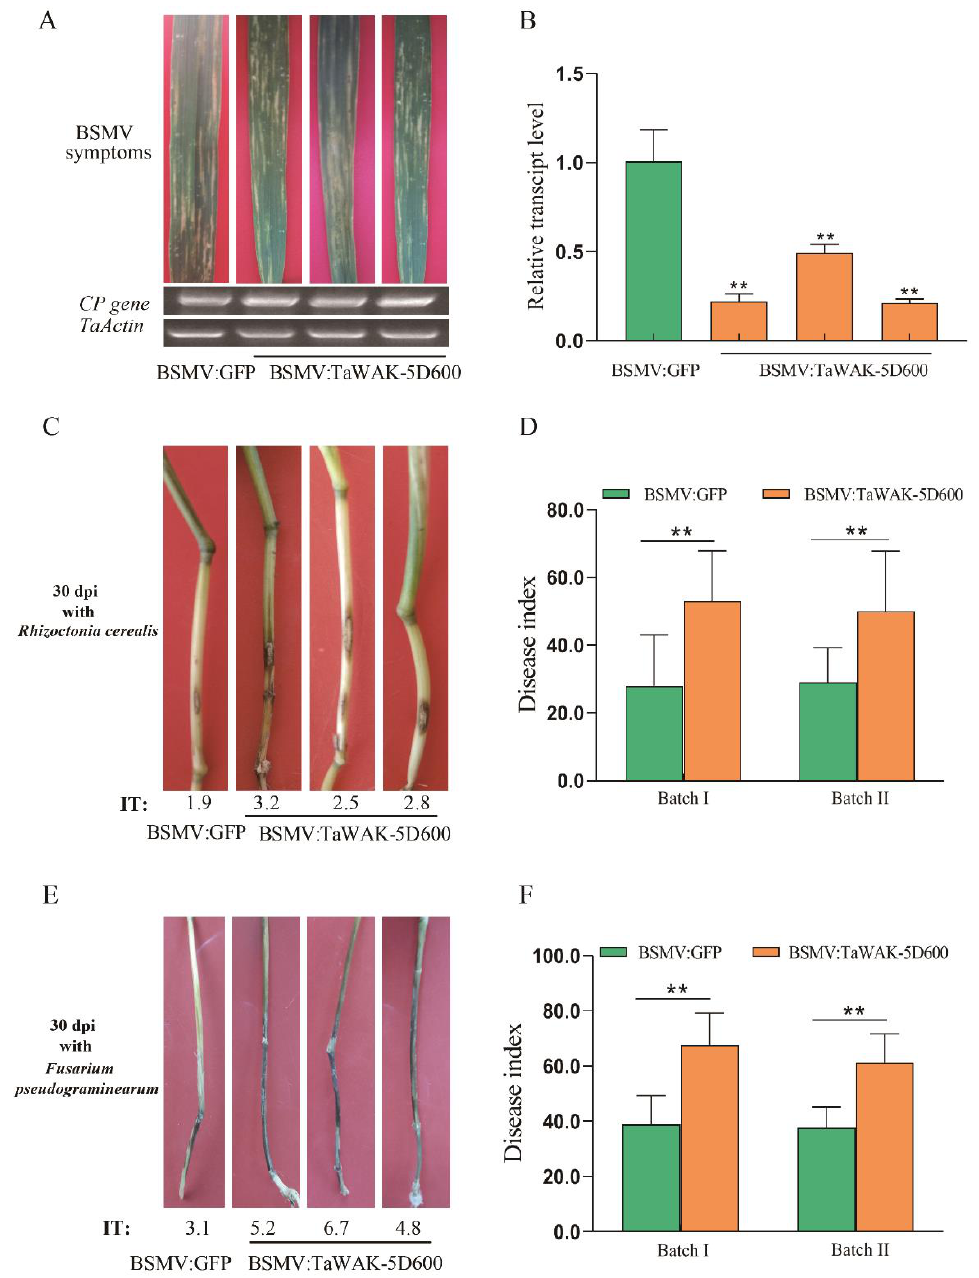
Figure 5. Silencing of TaWAK-5D600 -compromised wheat resistance both to sharp eyespot and Fusarium crown rot. ( A ) Typical BSMV symptoms on wheat leaves at 15 dpi infected with BSMV and transcripts of BSMV coat protein ( CP ) gene detecting by RT-PCR assays. ( B ) The silencing efficiency of TaWAK-5D600 detecting by RT-qPCR assay. The transcript level of TaWAK-5D600 in BSMV:GFP (control) wheat seedlings was set to 1. ( C ) Sharp eyespot symptoms on TaWAK-5D600 -silenced and BSMV:GFP (control) wheat plants at 30 dpi with R. cerealis . ( D ) Disease indexes (DIs) of TaWAK-5D600 -silenced and BSMV:GFP (control) wheat plants at 30 dpi with R. cerealis in two independent batches ( t -test: ** p < 0.01). ( E ) Fusarium crown rot symptoms on TaWAK-5D600 -silenced and control wheat plants at 30 dpi with F. pseudograminearum. ( F ) Disease index (DI) of TaWAK-5D600 -silenced and control wheat plants at 30 dpi with F. pseudograminearum WHF220 in two independent batches ( t -test: ** p < 0.01). Bars indicate SEs of the